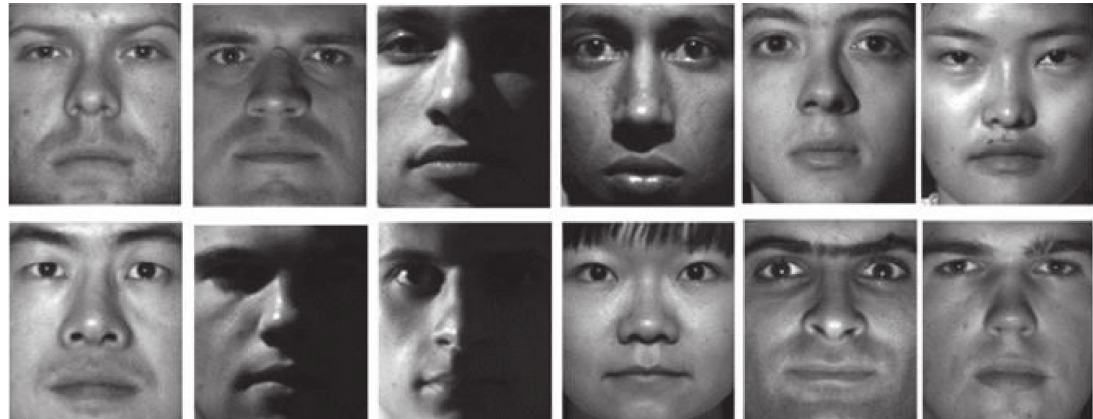
Figure 6: Examples of some different expressions of the face images in the Yale B dataset.